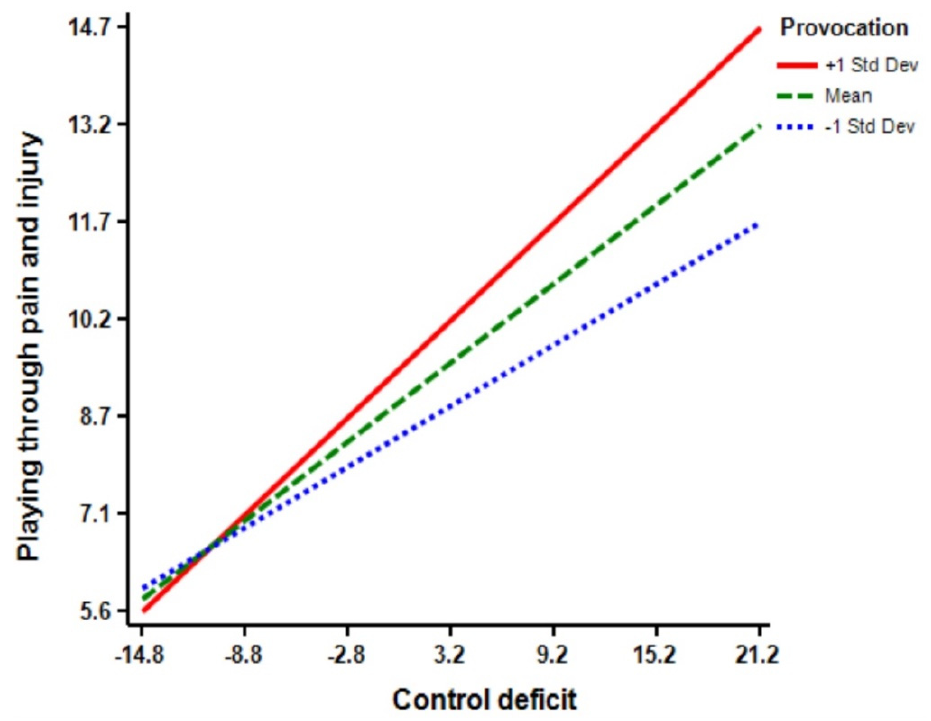
Figure 4. Provocation by control balance deficit interaction.